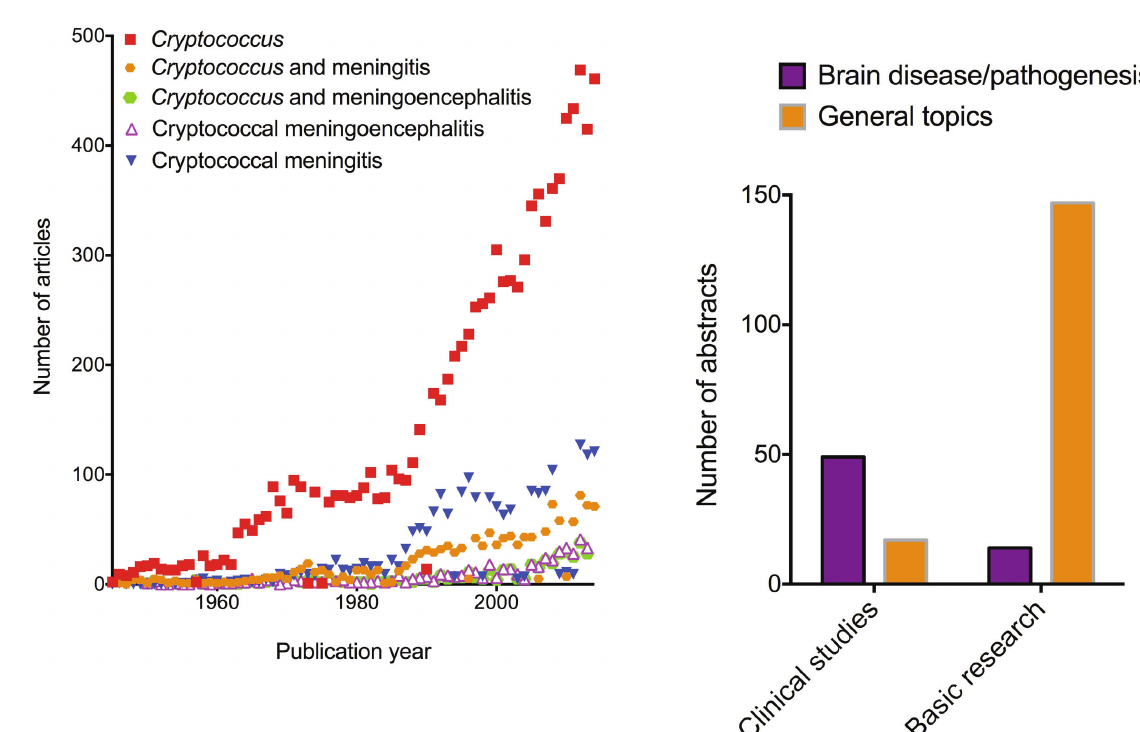
Fig. 1 - Pubmed-indexed papers on Cryptococcus and / or related brain diseases published between 1945 and 2014. The annual number of papers was obtained after a Pubmed (http:// www.ncbi.nlm.nih.gov/pubmed/) search using the keywords listed on the top of the Figure. Increasing trends were observed in all cases. Article quantification on Cryptococcus -related brain diseases (meningitis and meningoencephalitis) is likely overestimated, considering that the terms commonly used for pathology description are widely used to introduce regular articles and reviews in the Cryptococcus field.